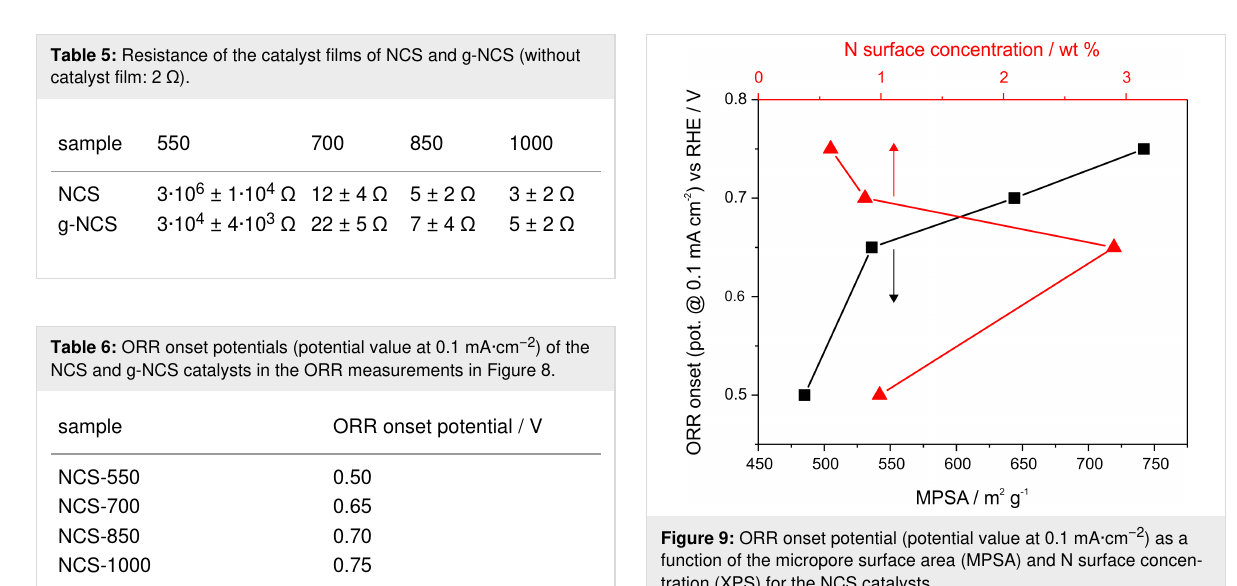
Figure 8: ORR measurements (cyclic voltammograms). (a) ORR disc current densities of the NCS catalysts and Pt/C, (b) ring current densities of the NCS catalysts, (c) hydrogen peroxide yield of the NCS catalysts, (d) ORR disc current densities of the g-NCS catalysts and Pt/C, (e) ring current densities of the g-NCS catalysts and (f) hydrogen peroxide yield of the g-NCS catalysts, 1600 rpm, 0.5 M H 2 SO 4 , 10 mV·s − 1 .